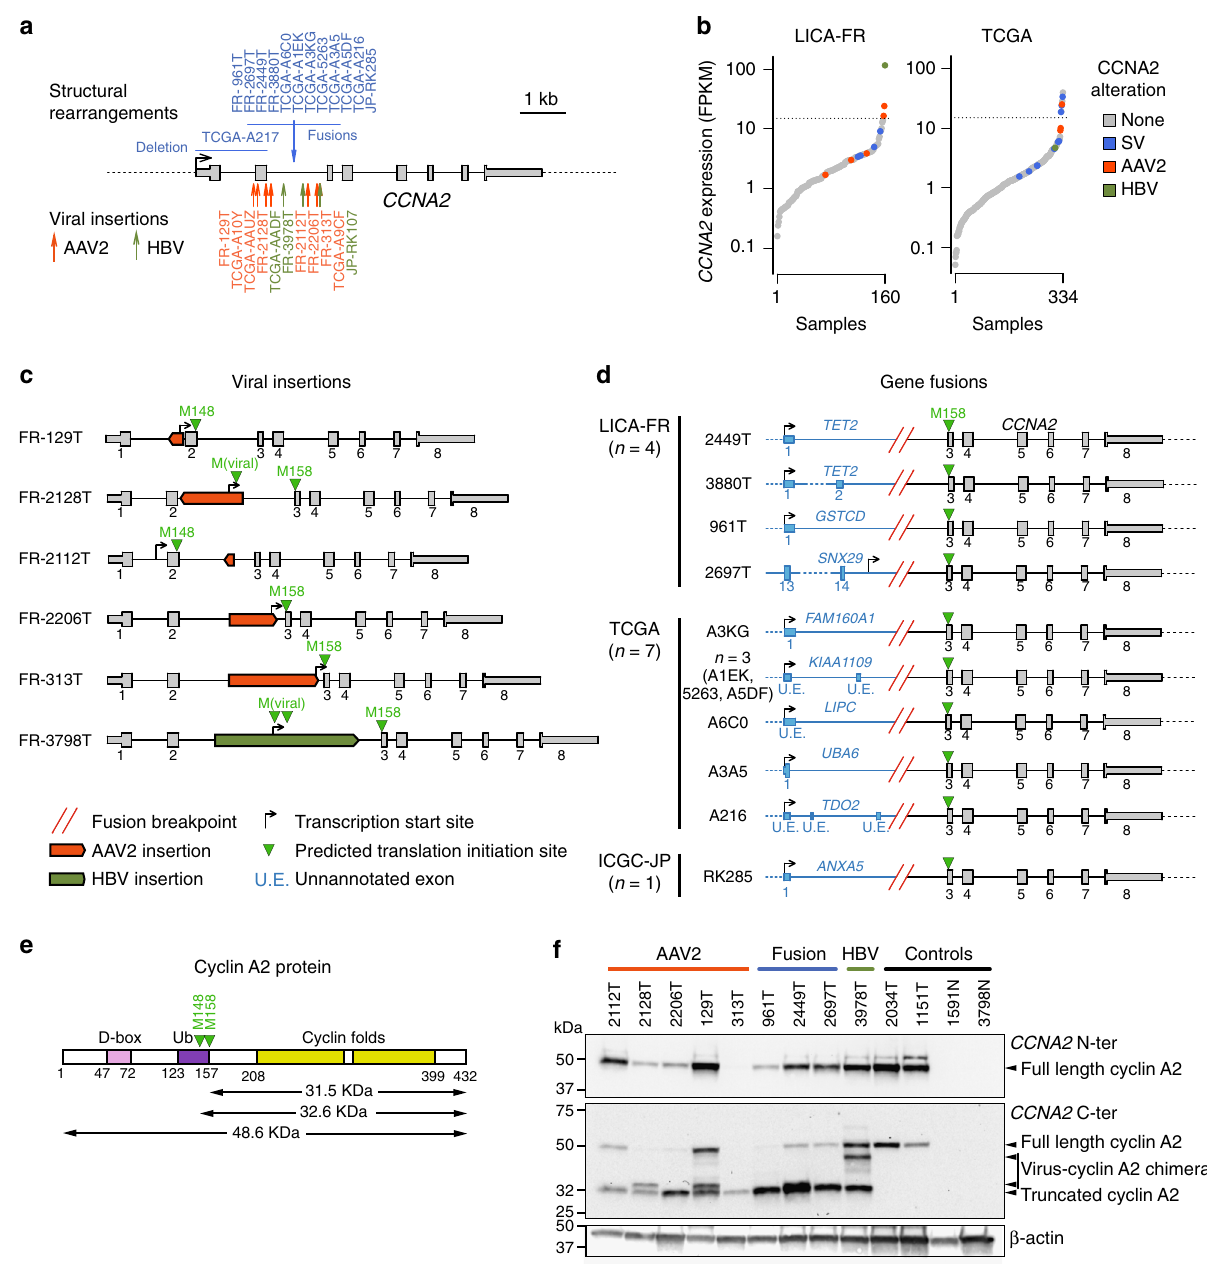
Fig. 1 Diverse mechanisms leading to CCNA2 activation in HCC. a Summary of structural rearrangements (top) and viral insertions (bottom) affecting CCNA2 gene identi fi ed in 751 HCC from the LICA-FR, TCGA and ICGC-JP cohorts. b Sorted CCNA2 expression (log scale) in the LICA-FR and TCGA cohorts. Gene expression was obtained from RNA-seq data and is given in fragments per kilobase of exons per million reads (FPKM). Samples harboring structural variants (SV) or viral insertions are indicated with a color code. c Functional consequences of AAV2 and HBV insertions in CCNA2 . Viral insertions identi fi ed in the LICA-FR cohort were precisely mapped using WGS or viral capture data, and RNA-seq reads were aligned on the reconstructed chimeric DNA to identify the transcription start sites and predicted translation initiation sites of abnormal transcripts. d CCNA2 fusions identi fi ed in the LICA-FR, TCGA and ICGC-JP cohorts. The transcription start site of the fusion transcript is represented together with the predicted translation initiation site. Fusions with KIAA1109 , LIPC and TDO2 involve 5 ′ exons not annotated in transcript databases but expressed in normal liver. e Schematic representation of cyclin A2 protein with functional domains. D-box Destruction box; Ub, Ubiquitination targeting sequences. f Western blot analysis of cyclin A2 using antibodies targeting the N-terminal (top) or C-terminal (middle) domains. Tumors with viral insertions or gene fusions are compared with tumors without CCNA2 alteration and non-tumoral liver